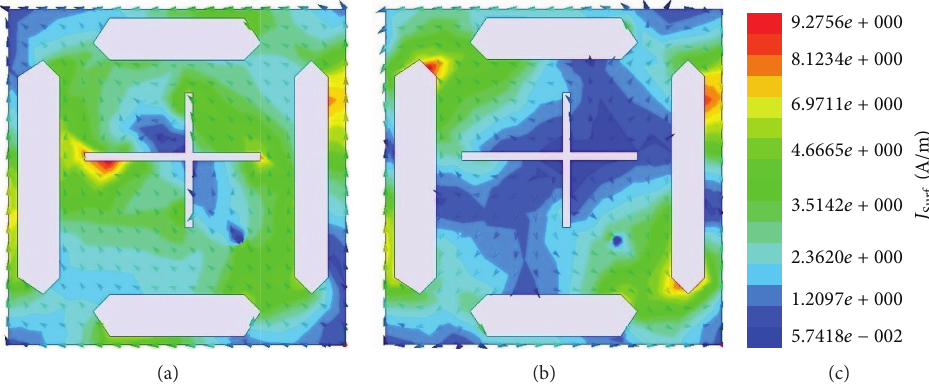
Figure 7: Surface current distributions at (a) 2.18 GHz, (b) 3.30 in phase 0 ∘ (c) scale.